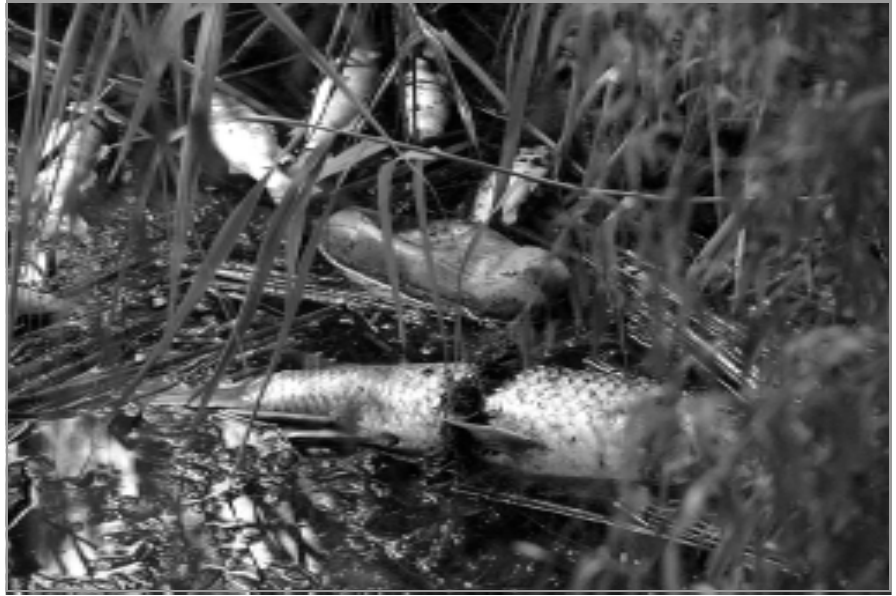
Illustration 7: Thousands of fish died in January 2006 as a result of sewage effluent flowing into the Vaal River Barrage.